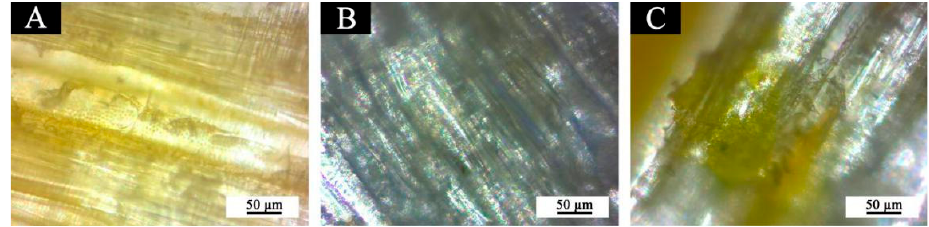
Figure 7. OM: ( A ) basswood, ( B ) basswood coated with a topcoat without microcapsules, ( C ) basswood coated with a topcoat containing 15% fluorane microcapsules.